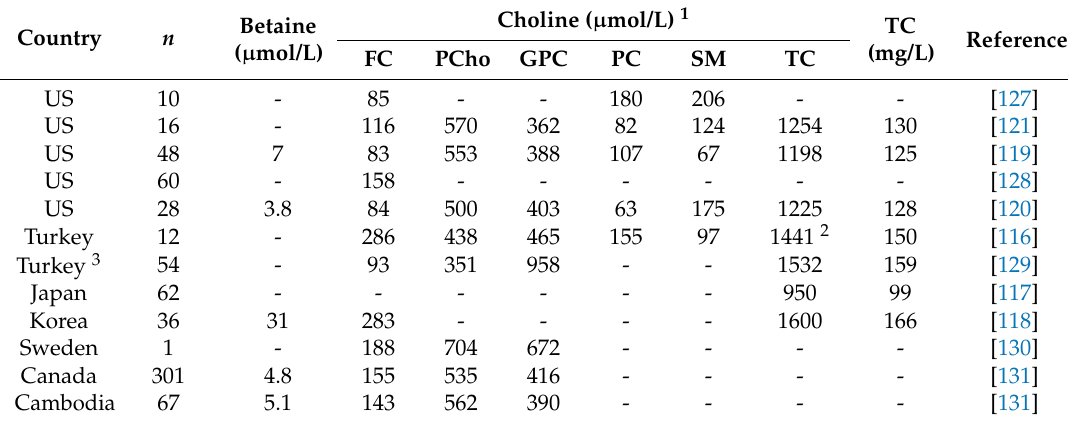
Table 1. Studies reporting choline concentrations in mature human